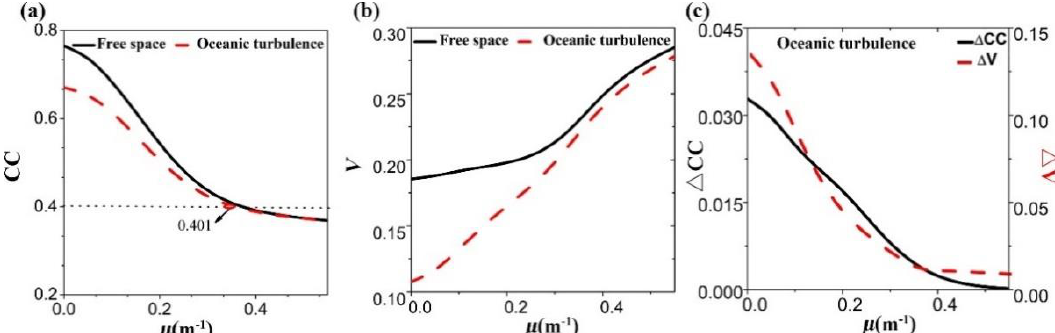
Figure 3. ( a ) Variation of CC (quality of the image) with the twist factor; ( b ) Variation of V with the twist factor μ . ( c ) Changes of the relative difference of quality and visibility of the image of double slits with the twist factor.